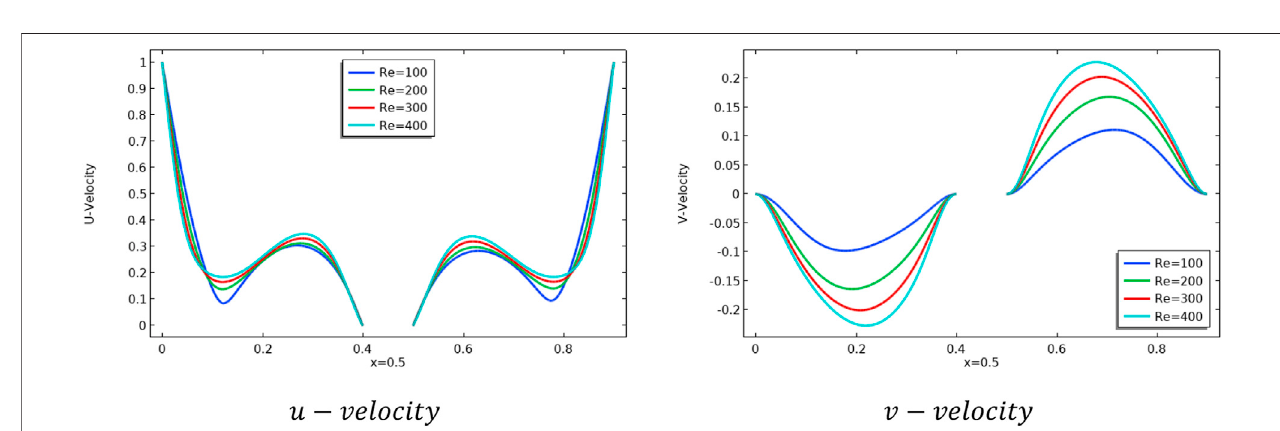
FIGURE 11 | Velocity line pro fi le against Re at position x (cid:2) 0 . 5.